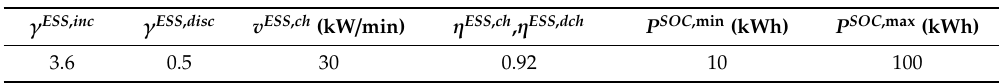
Table A3. EV data.